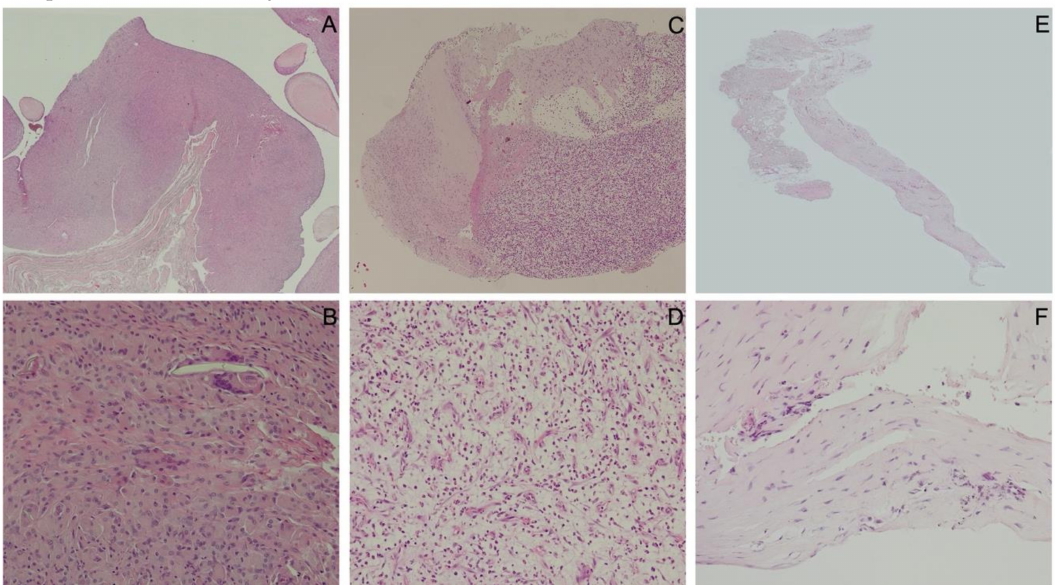
Figure 3. Histopathological specimens of Morawietz / Krenn Type I (( A ): scanning magnification view of 4-fold and ( B ): 20-fold magnification); Type II (( C ): scanning magnification view of 4-fold and ( D ): 20-fold